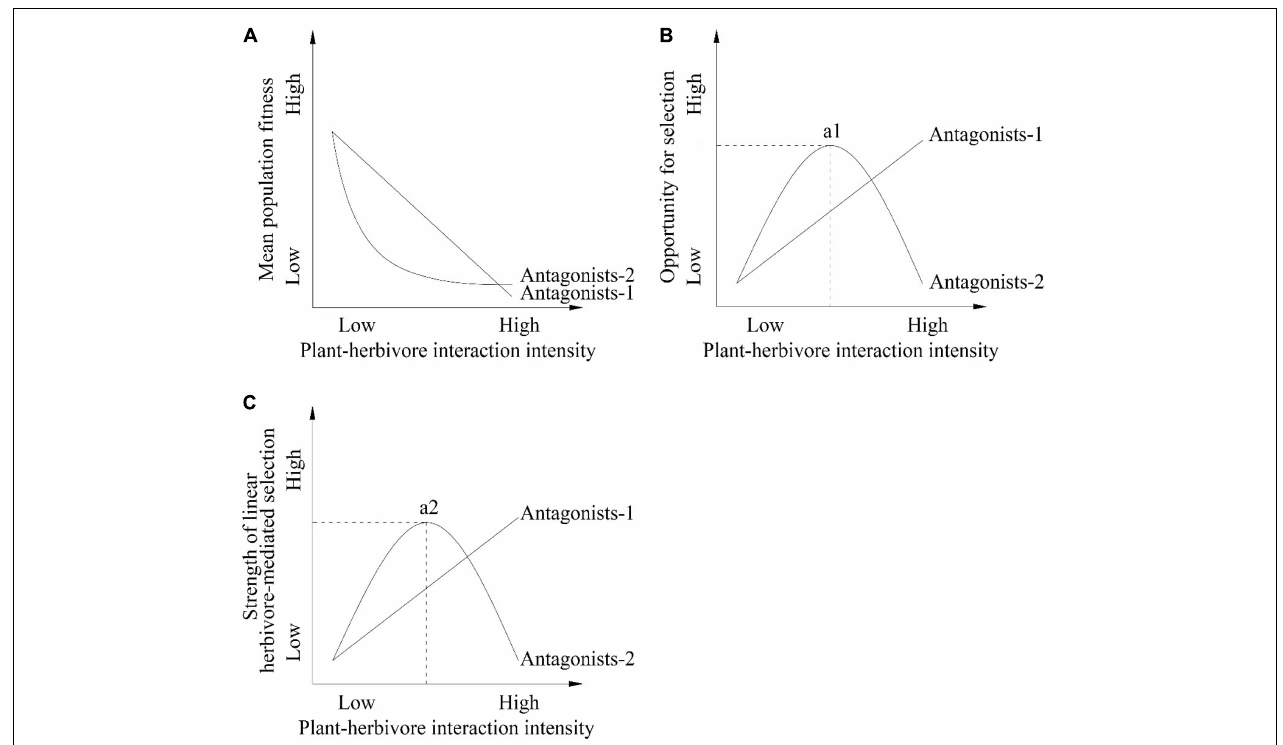
FIGURE 1 | Hypotheses and predictions of the associations between plant-herbivore interaction intensity and (A) mean population fitness (B) opportunity for selection (C) strength of linear herbivore-mediated selection among populations. Mean population fitness (A) can decrease with increasing intensity of plant-herbivore interactions or first decrease with the increasing intensity of plant-herbivore interactions and then stabilize when interaction intensity is high among populations because the physiological and biochemical plant defense mechanisms and/or pollinators may reduce the negative effect of herbivores on mean population fitness. In contrast, the opportunity for selection (B) and strength of linear herbivore-mediated selection (C) can increase with increasing plant-herbivore interaction intensity or first increase with increasing plant-herbivore interaction intensity and then decrease when the intensity of plant-herbivore interactions are high among populations. In the antagonists-1 scenario the effect of herbivores on the host plant are not influenced by other factors. In contrast in the antagonists-2 scenario the effect of herbivores on the host plant are influenced by other factors such as pollinators and/or the physiological and biochemical defense of the host plant. The a1 and a2 points represent the greatest opportunity for selection and the strongest strength of linear herbivore-mediated selection by antagonists-2 prediction, respectively. The dashed lines in (B,C) represent the hypothesis of plant-herbivore interaction intensity when there is the greatest opportunity for selection and the strongest strength of linear herbivore-mediated